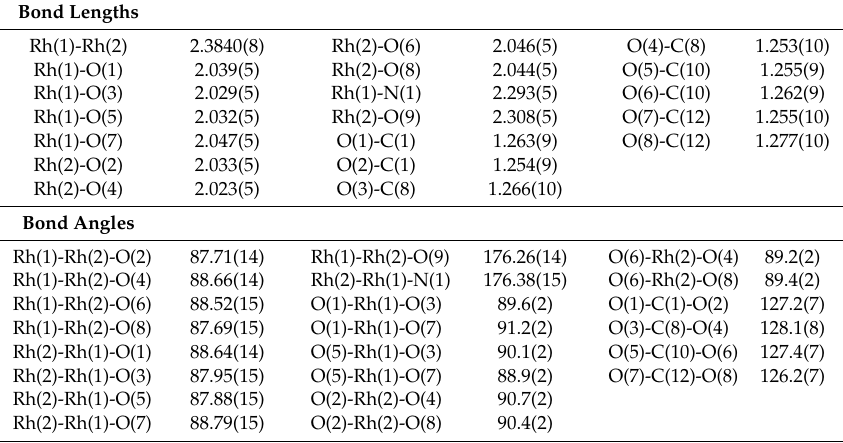
Table 2. Structural parameters of 1P (bond length: Å, bond angle: ◦